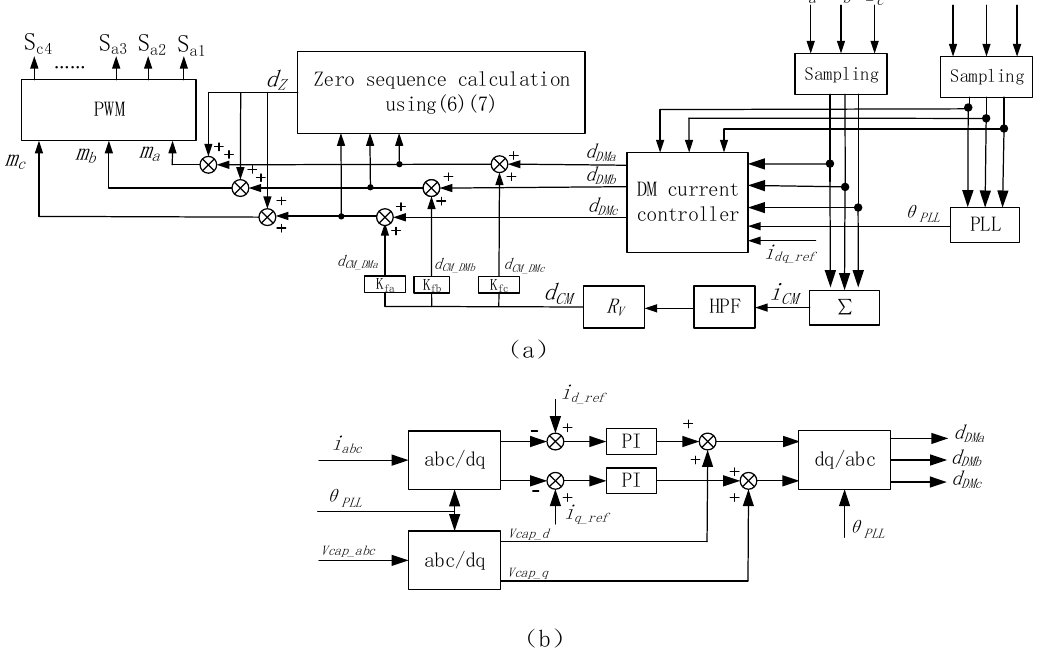
Figure 15. ( a ) The implementation of virtual negative resistor based AD (VNRBAD) for DPWM application. ( b ) The DM current controller.